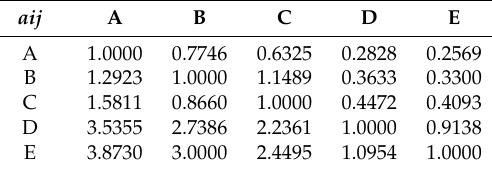
Table 7. Final judgment matrix.